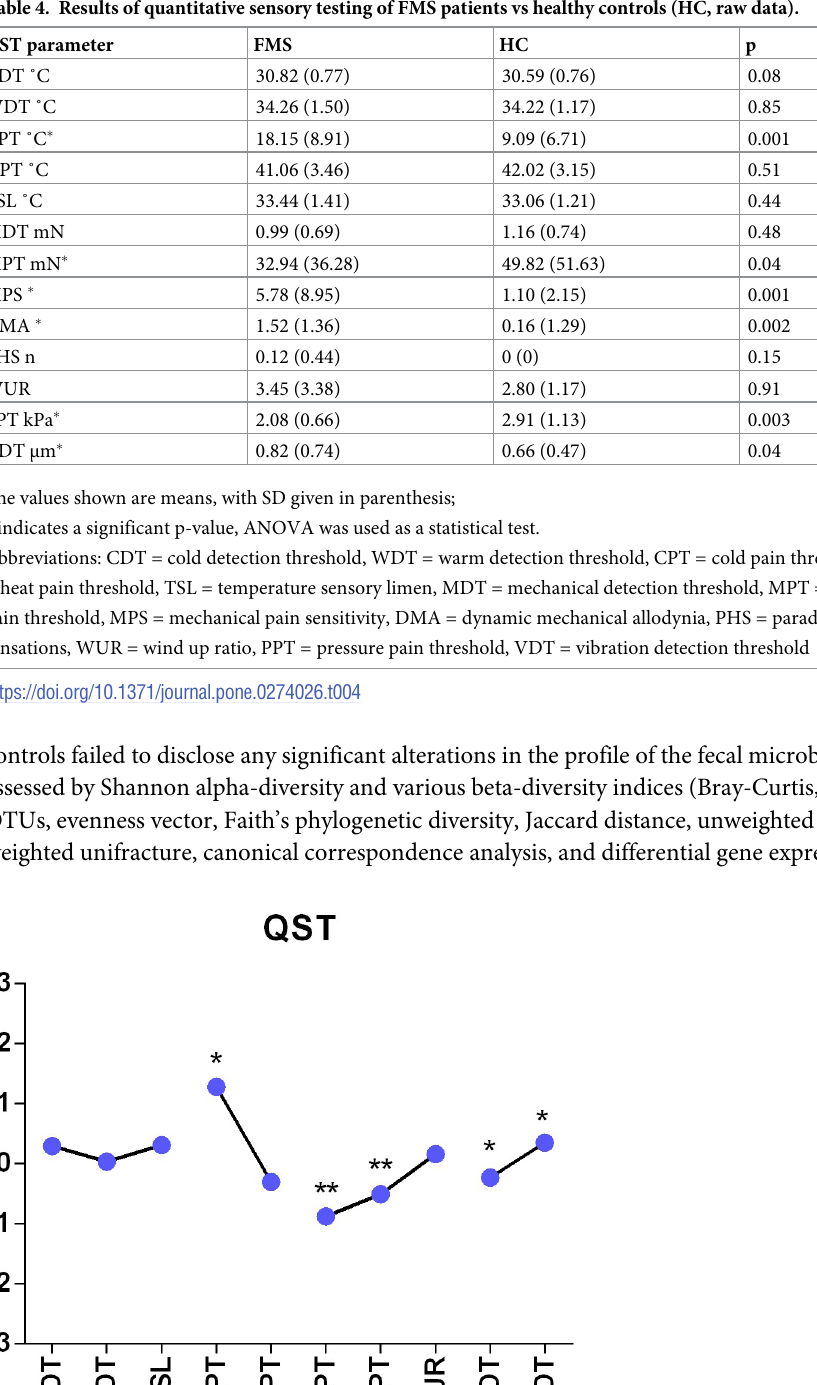
Table 4. Results of quantitative sensory testing of FMS patients vs healthy controls (HC, raw data).